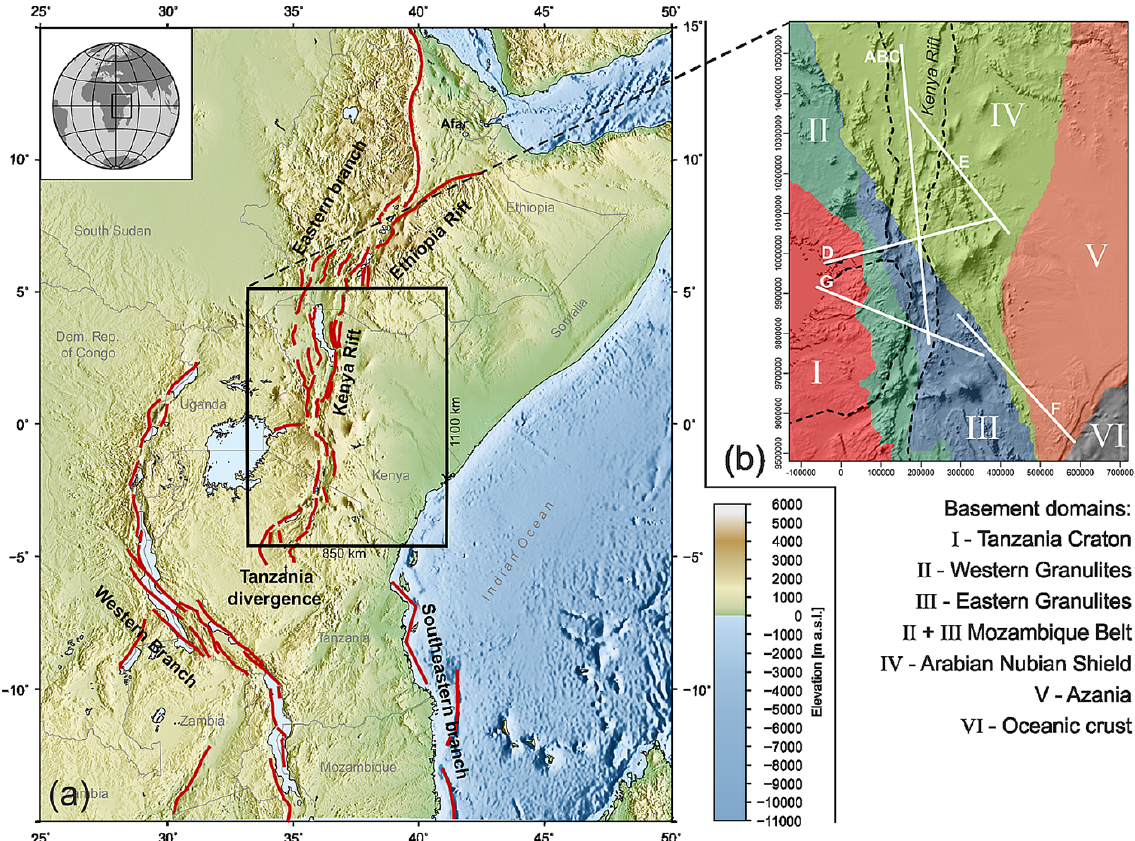
Figure 1. (a) Topography and bathymetry of the East African Rift System (EARS; from ETOPO1; Amante and Eakins, 2009); major faults of rift branches are from Chorowicz (2005); black frame marks the modelled study area. (b) Precambrian basement domains modified from Fritz et al. (2013); note that over wide parts of the region, these proposed basement domains are covered by Mesozoic–Cenozoic sediments and volcanics so that their spatial distributions are locally subjected to interpolation uncertainties; solid white lines represent the KRISP refraction seismic profiles (Khan et al., 1999); distribution of oceanic crust derived from Müller et al. (2008); surface expressions of the Kenya and Nyanza rifts (dashed lines) have been derived from Beicip (1987) and Milesi et al.